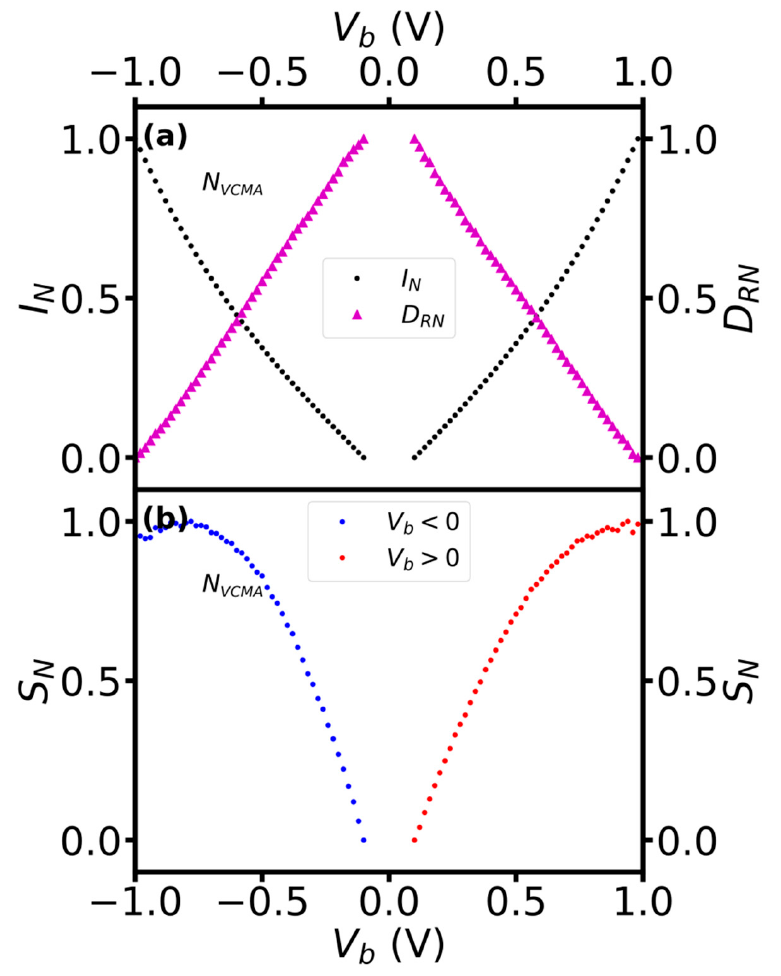
Figure 7. The normalized dependence of current (dots), derivative of R-H (triangles) ( a ) and sensitivity ( b ) on bias voltage of the sensors without VCMA modification.